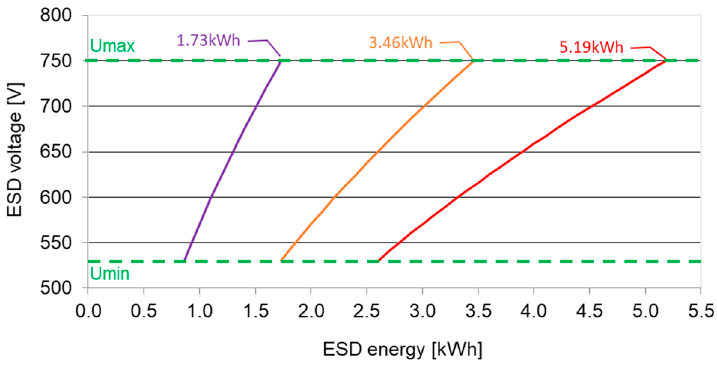
Figure 6. ESD charging/discharging characteristic for DOD 50% for different ESD energy capacity.